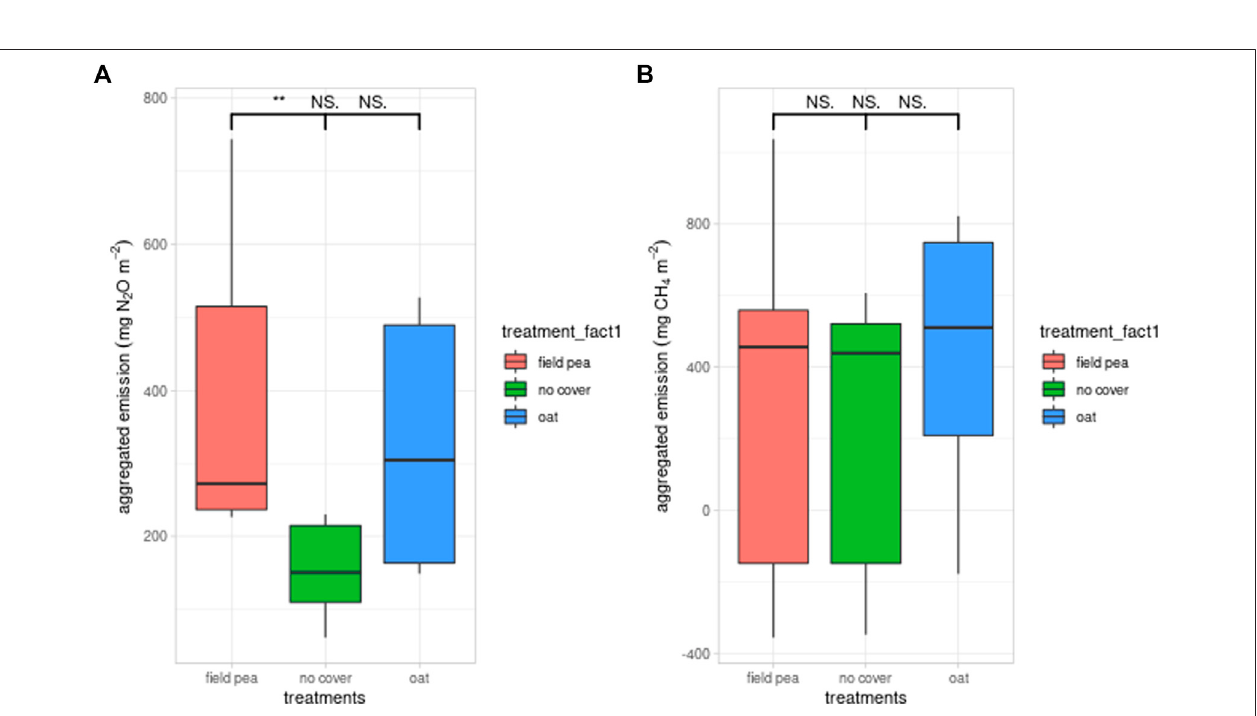
Frontiers in Environmental Science |